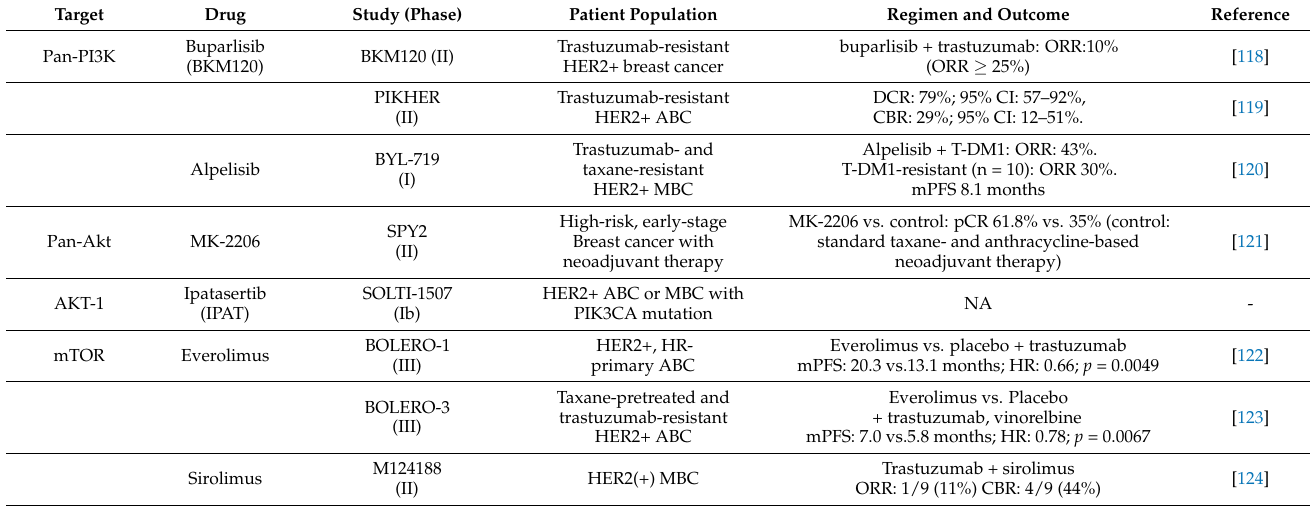
Table 4. Clinical trials of PAM inhibitors in HER2+ breast